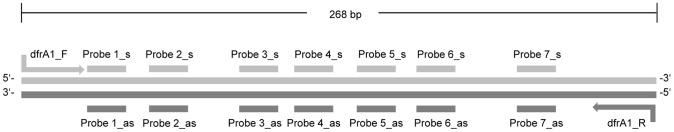
Position and nomenclature of the primers and probes within their target gene dfrA1.The sense strand, forward primer, and probes in sense configuration (s) are displayed in light grey, whereas antisense stand, reverse primer, and probes in antisense configuration (as) are displayed in dark grey, respectively.